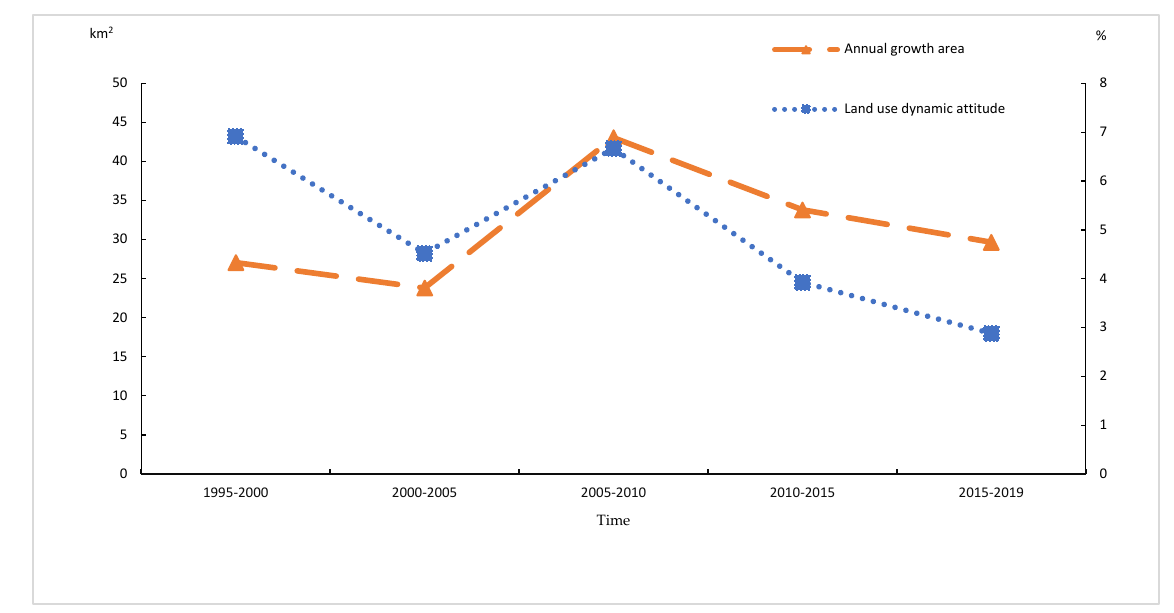
Figure 3. Area of the UCL change and UCL dynamic attitude in Wuhan, 1995–2019 (Divide the years